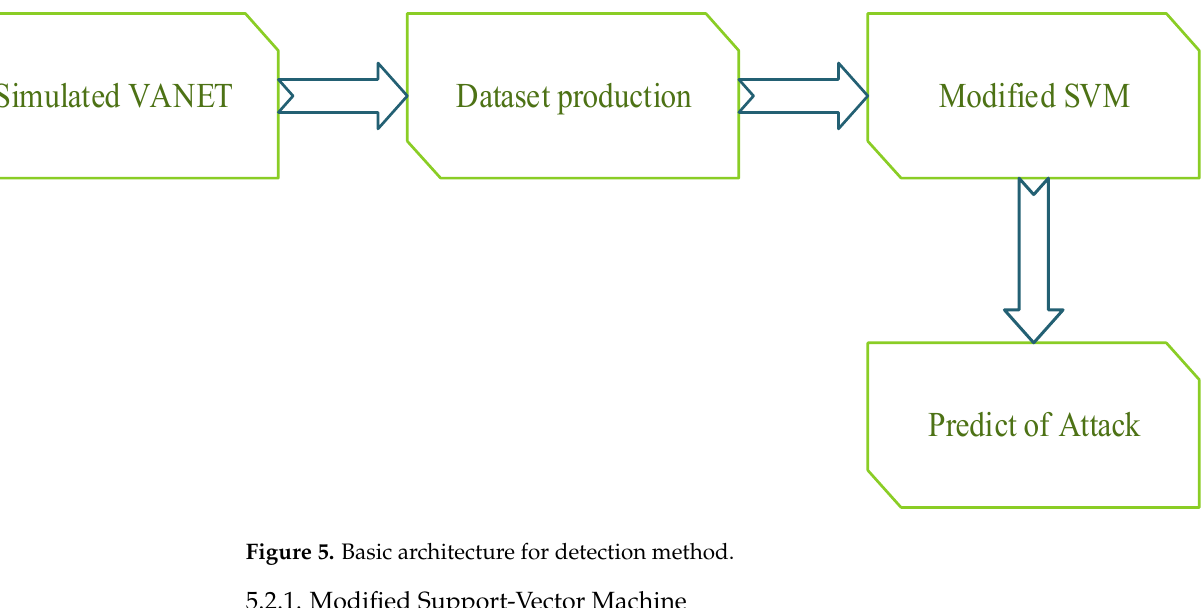
Table 1. Vehicle placement in the VANET.